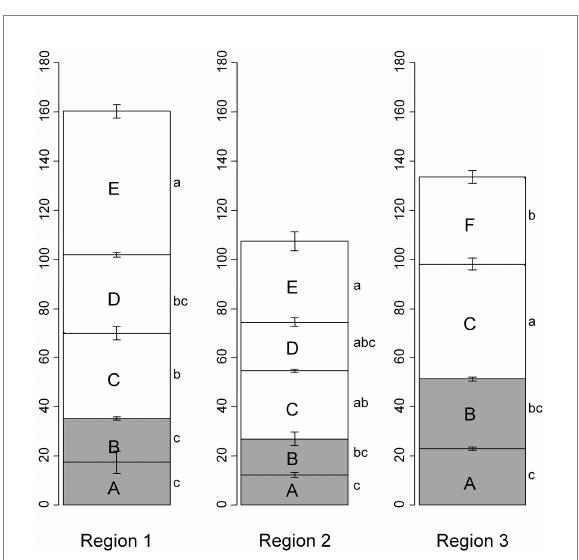
FIGURE 5 Mean specificity score of habitats and standard error over three (four for region three) years in the three regions (comparative contribution to regional diversity). (A) conventional meadow, (B) crop field, (C) BPA meadow, (D) BPA orchard, (E) BPA hedge, (F) wildflower strip BPA. Specificity values with the same letter are not significantly different (Tukey’s hsd, p < 0.05).